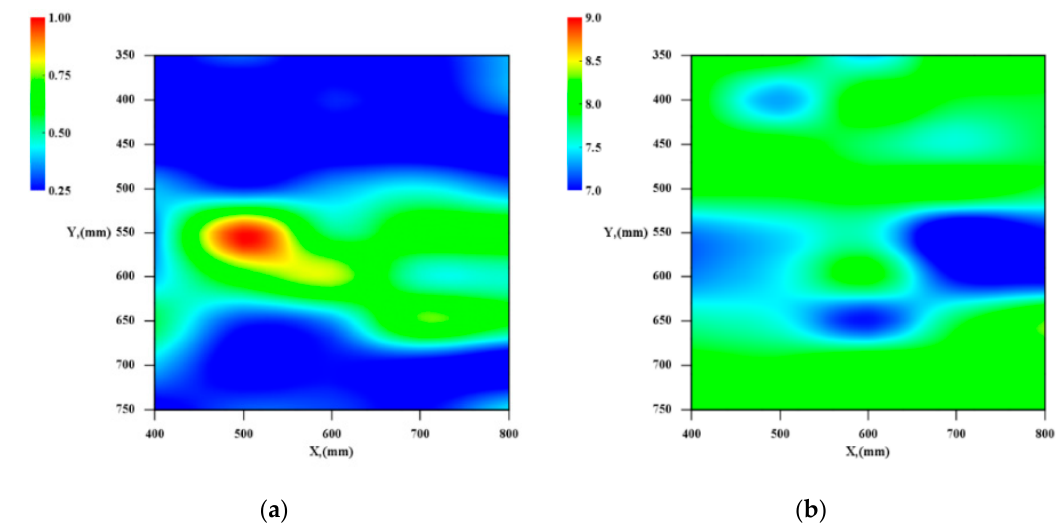
Figure 22. Contours of the evaluation results for Case_2: ( a ) DVA; ( b ) Dominant frequency.